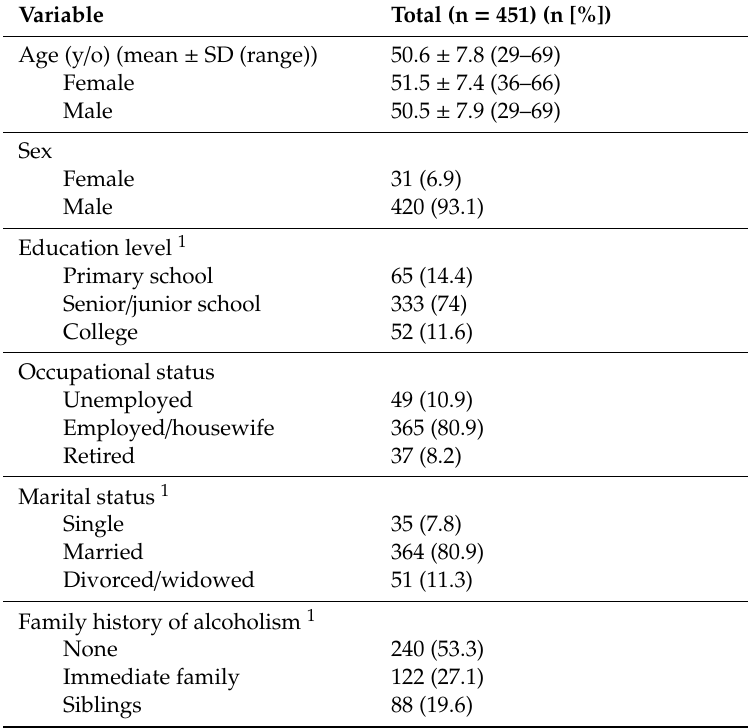
Table 1. The demographic characteristics of the liver transplantation (LT) recipient